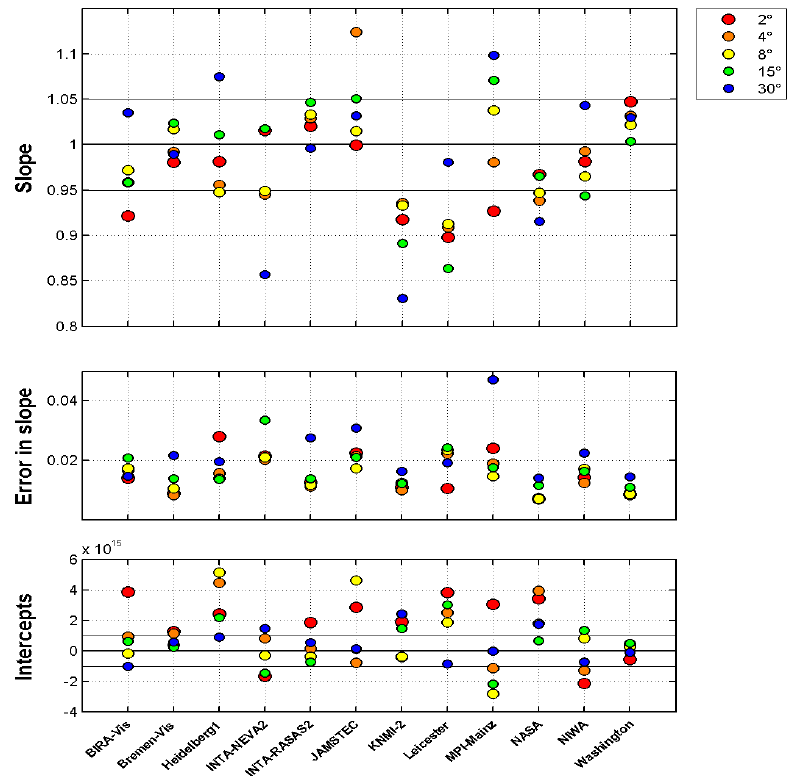
Fig. 8. Straight-line slopes and their errors of NO 2 slant columns against those of the reference data set, for each instrument at visible wavelengths, for clear sunny mornings only. Colours refer to elevation angles shown top right. Note the similarity to Fig. 6 in differences from unity slope for many instruments, but with larger scatter and errors because the number of data points is much smaller.